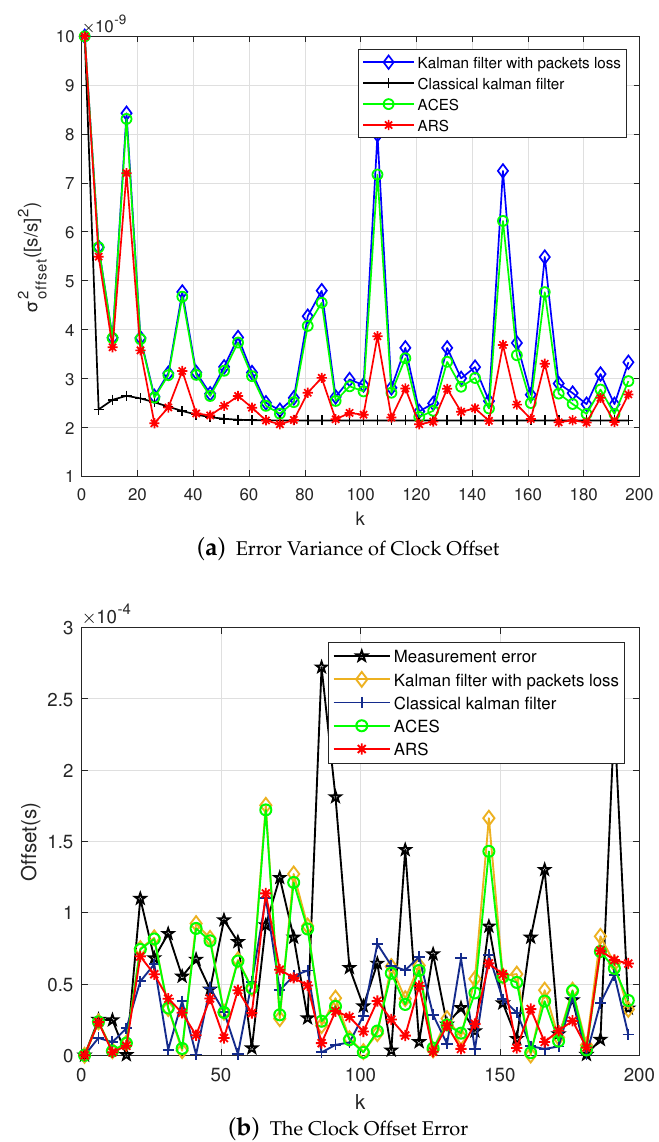
Figure 9. Clock Offset Error and Variance of the Second-order Kalman Filter in Single-hop